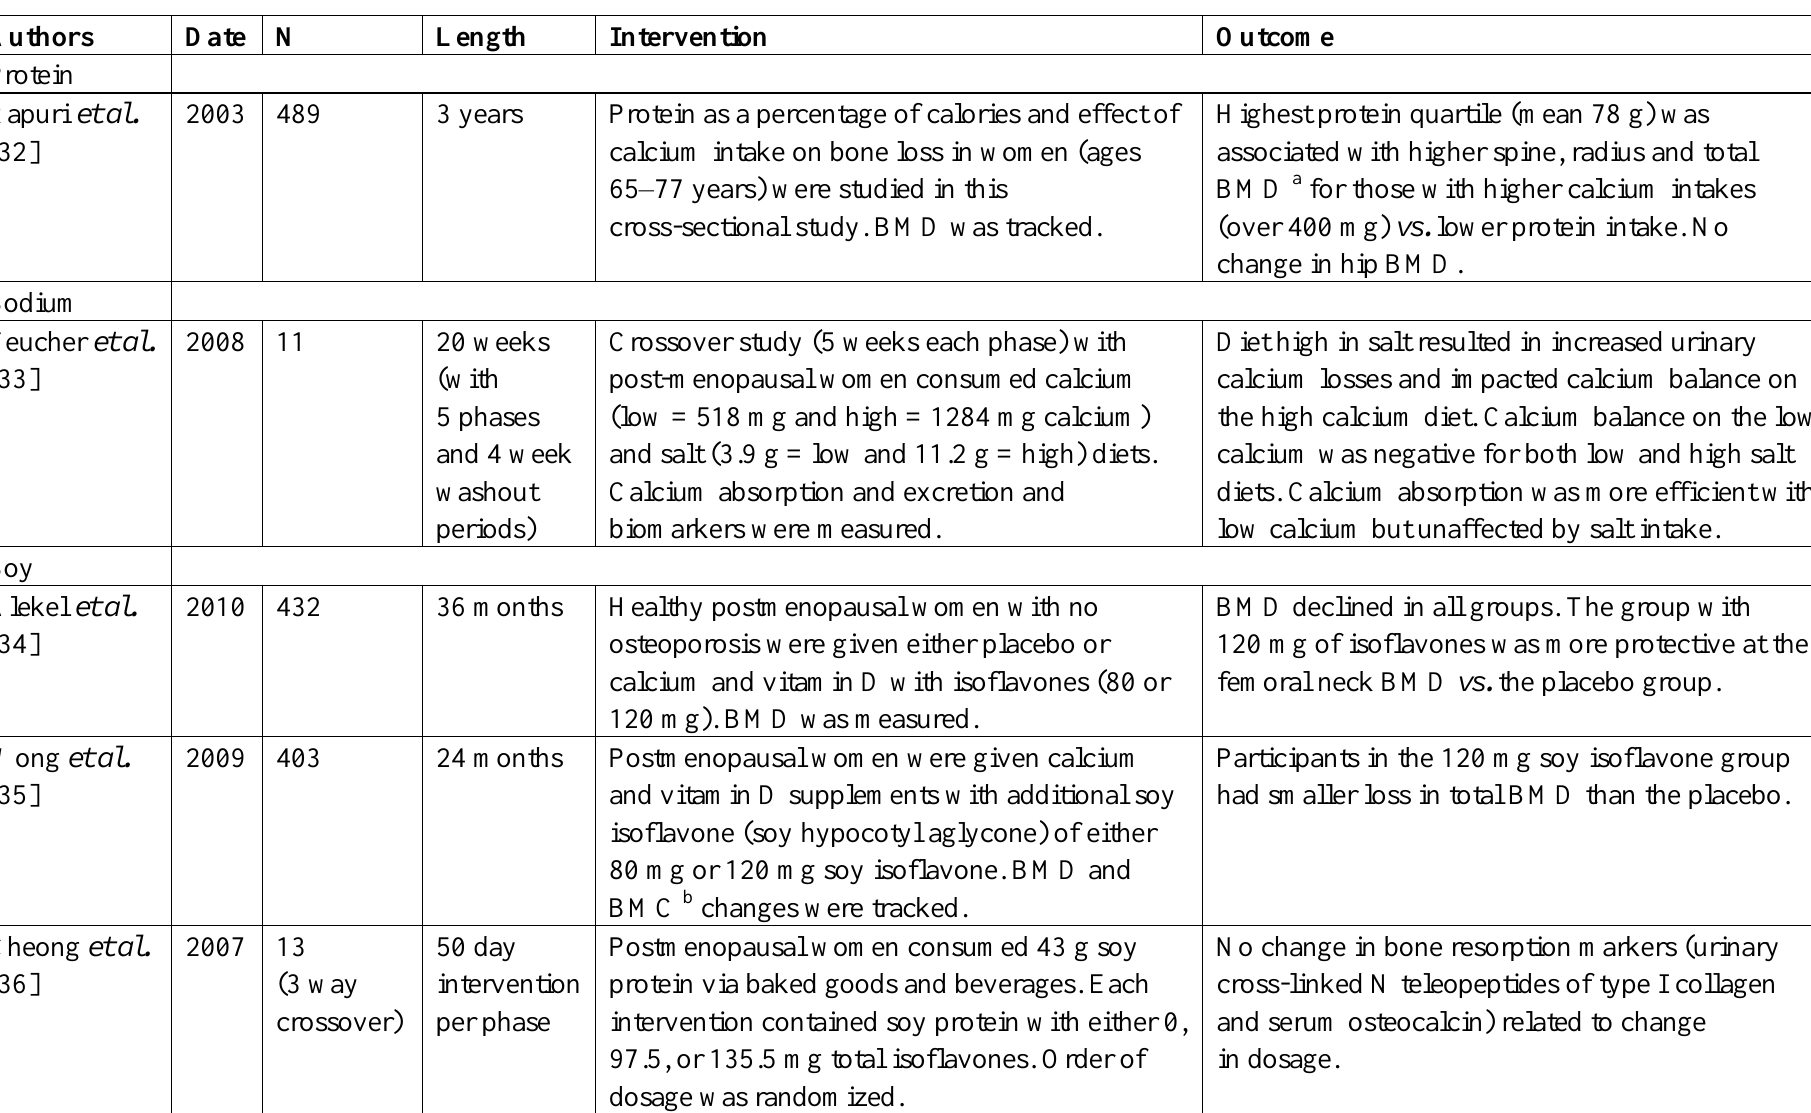
Table 3. Interventions using bone-healthy nutrients addition to calcium and vitamin